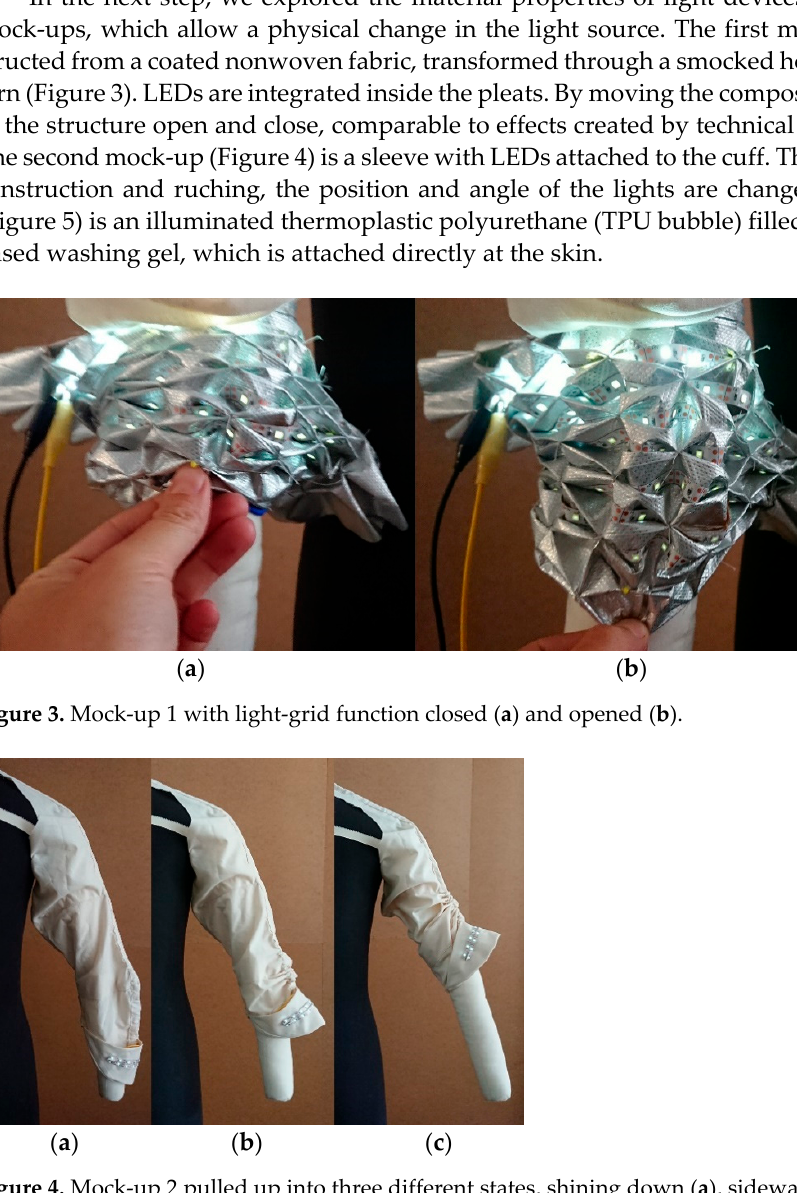
Figure 4. Mock-up 2 pulled up into three different states, shining down ( a ), sideways ( b ) and up- wards ( c